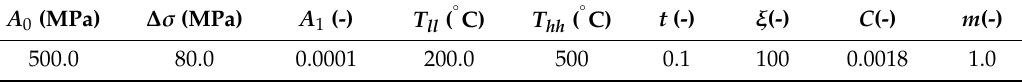
Table 1. Modified JC model parameters for normalized C45E steel.